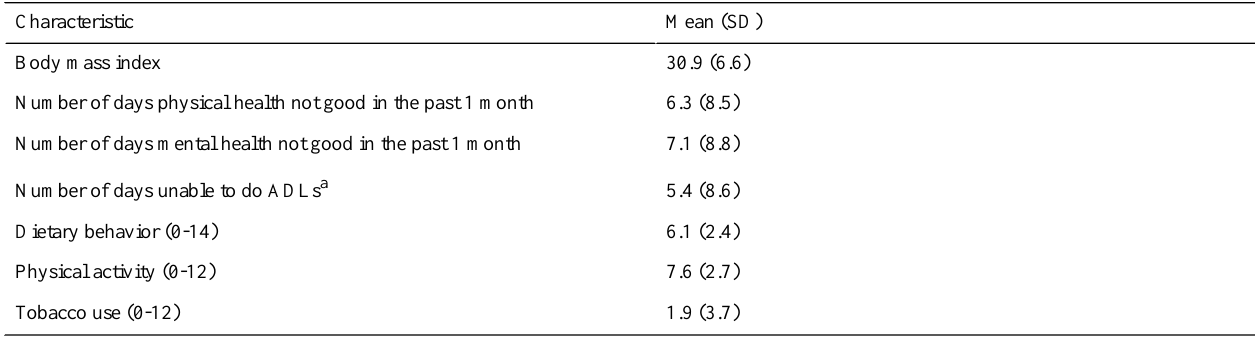
Table 3. Health status and health behavior assessment of participants (n=109).